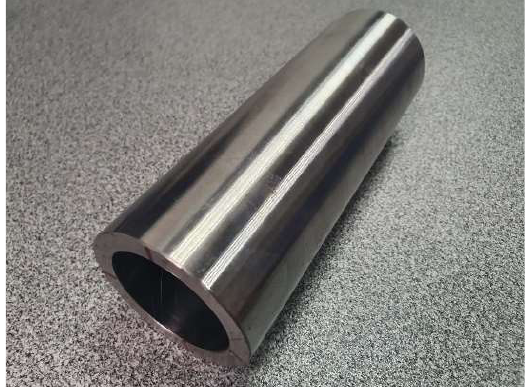
Figure 1. Steel St-52 cylinders.